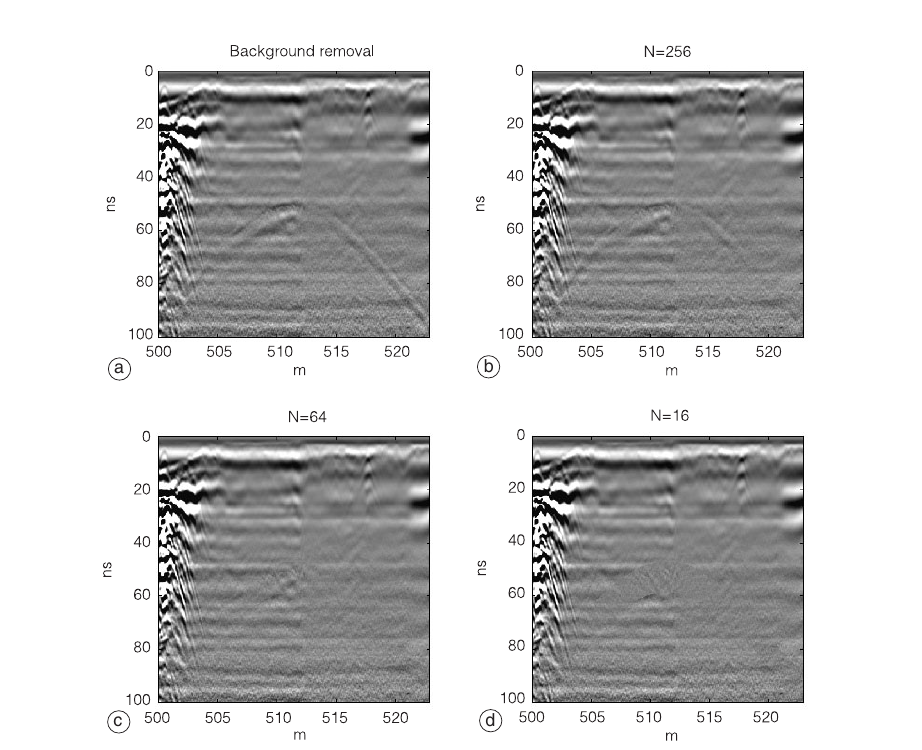
Fig. 10a-d. Example 3: comparison of the results obtained for surface-scattering removal by means of time- domain methods in the hyperbolically windowed domain (background removal and subtraction of a running average computed over different number of traces, N